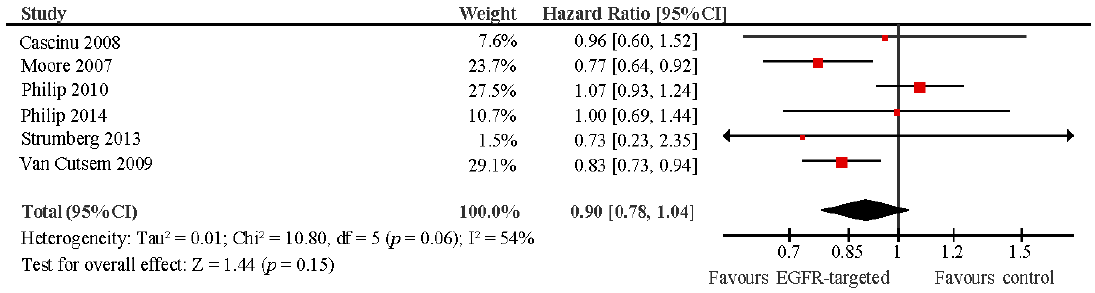
Figure 2. Forest plot showing hazard ratio for progression-free survival for addition of EGFR-targeted treatment to chemotherapy versus control. Experimental arm: EGFR-targeted therapy + chemotherapy; Control: chemotherapy; CI: confidence interval.